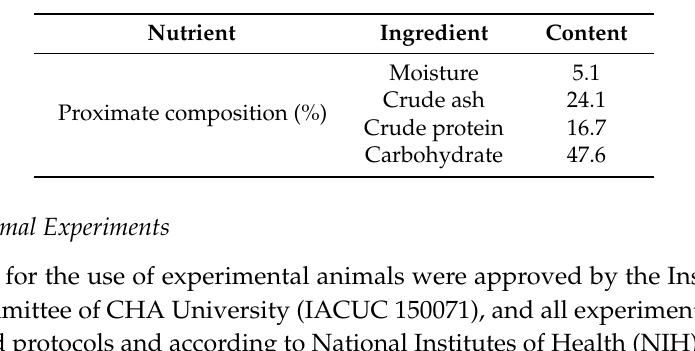
Table 1. Gelidium elegans extract (GEE)